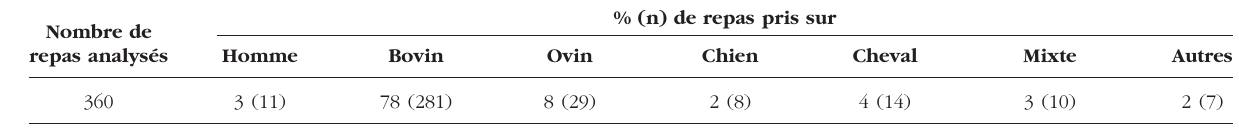
Tableau IV. – Identification de l’origine des repas sanguins d’ An. labranchiae à Larache,